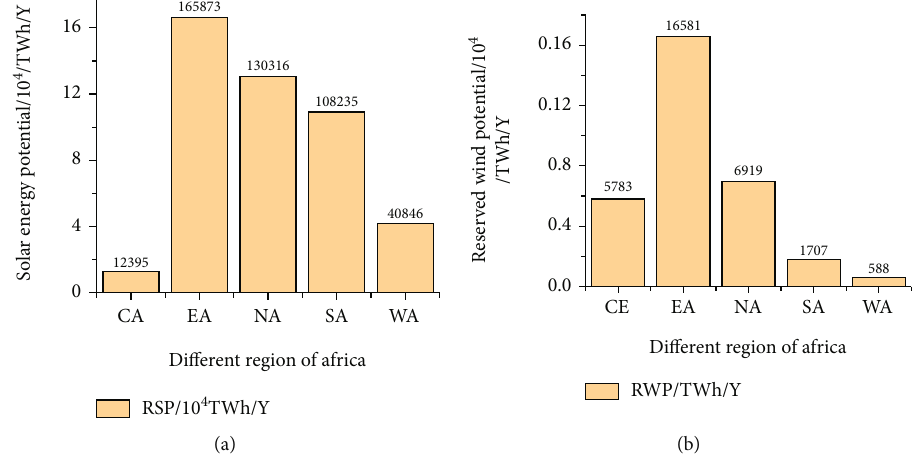
Figure 6: (a) Solar potential; (b) wind energy potential of di ff erent African regions per TWh/year from 2010 to